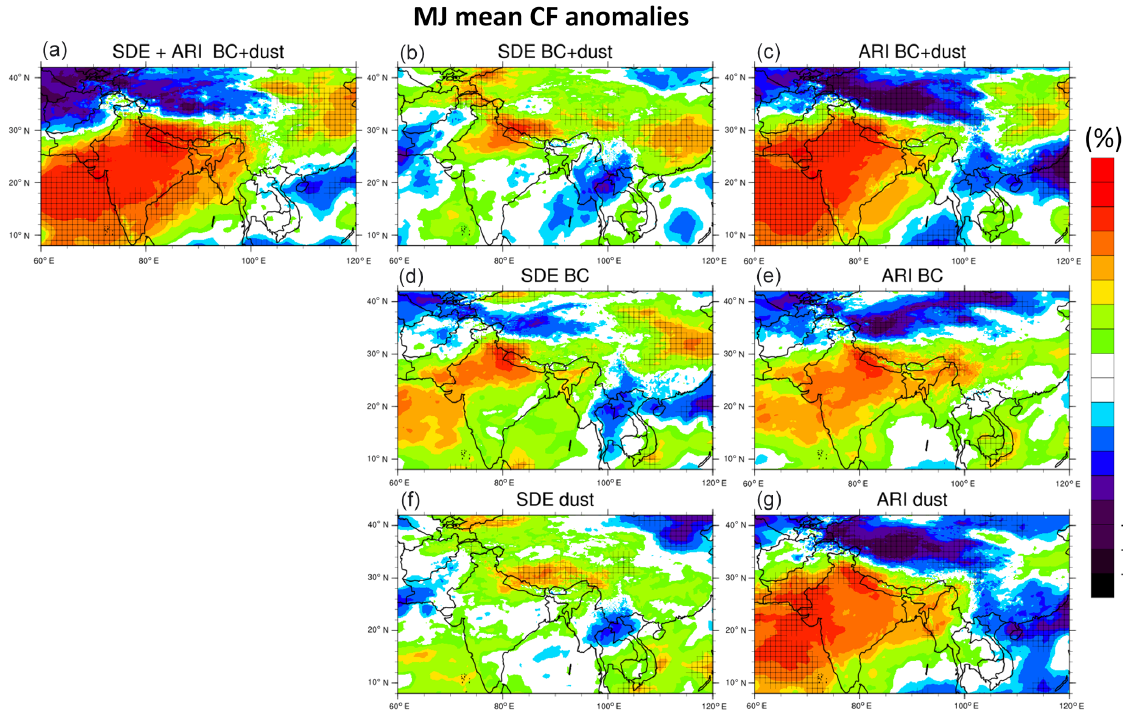
Figure 10. Same as in Fig. 6, but for cloud fraction (CF) (%).